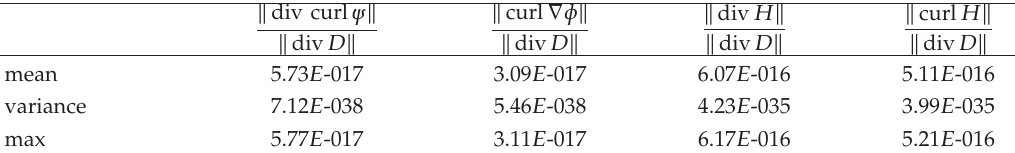
Table 1: Random second-order tensor fitting error.